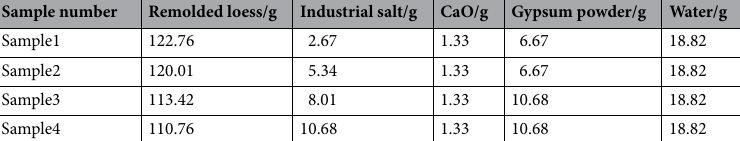
Table 3. Material quality of big ring knife